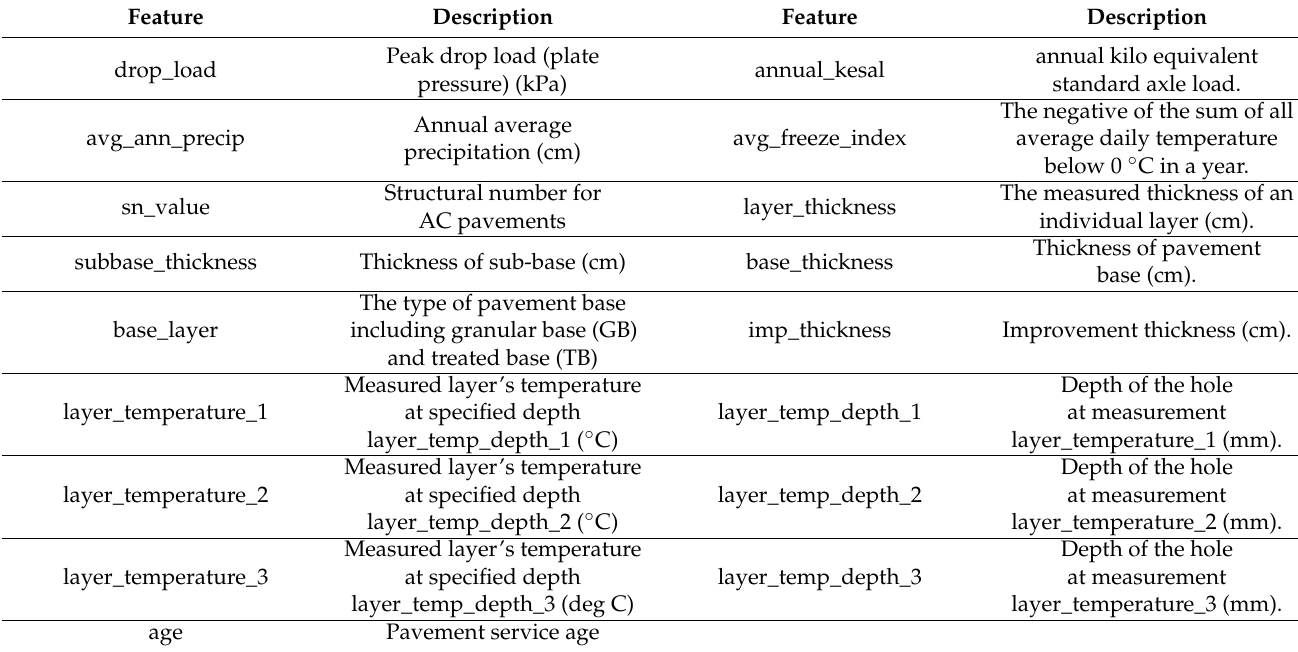
Table 1. Brief description of